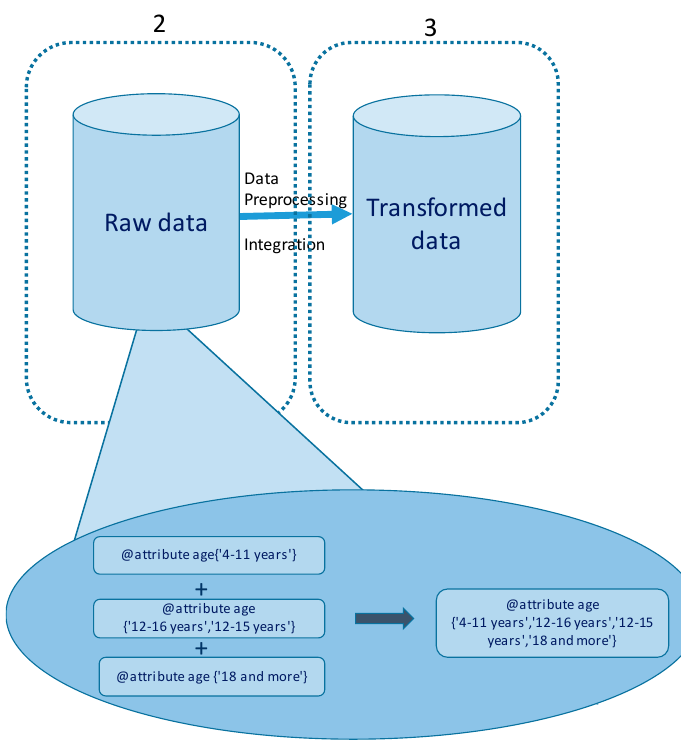
Figure 2. Integration of one of the variables from Table 1.